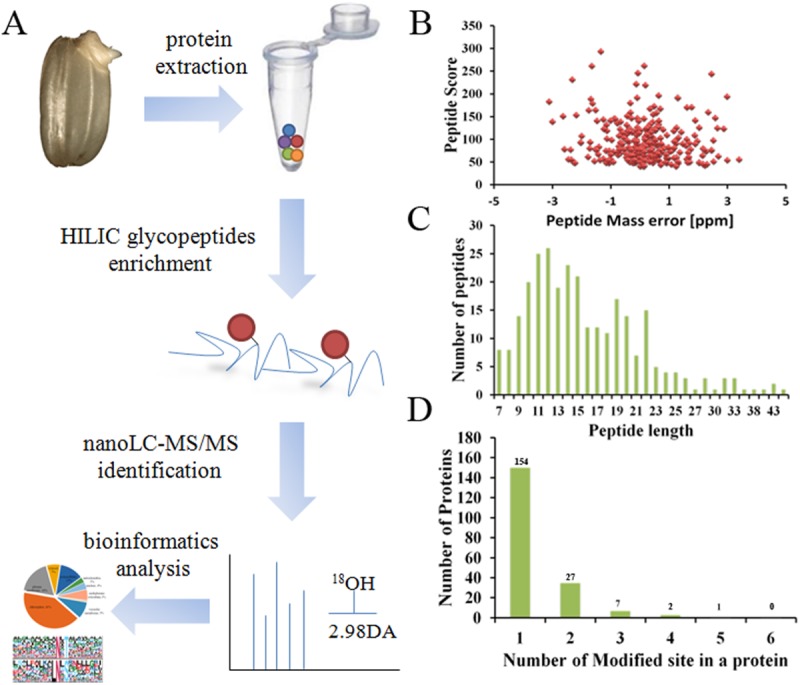
(A) Workflow of the N-glycosite mapping of rice germinating embryos; (B) Mass error of all the identified peptides; (C) length distribution of all the identified peptides; (D) glycosylation modification frequency on identified proteins.